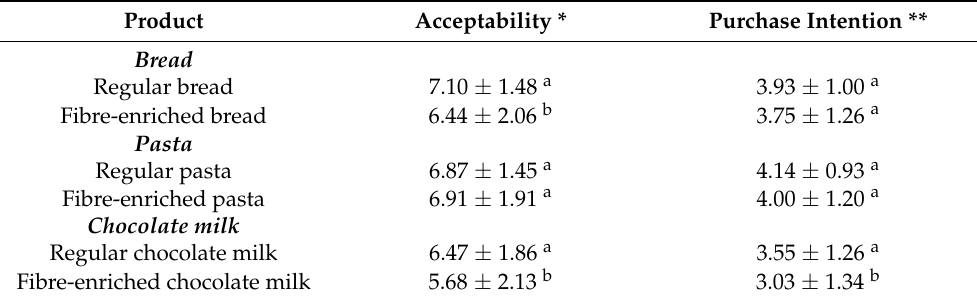
Table 5. Acceptability and purchase intention for bread, pasta and chocolate milk; regular and fibre-enriched